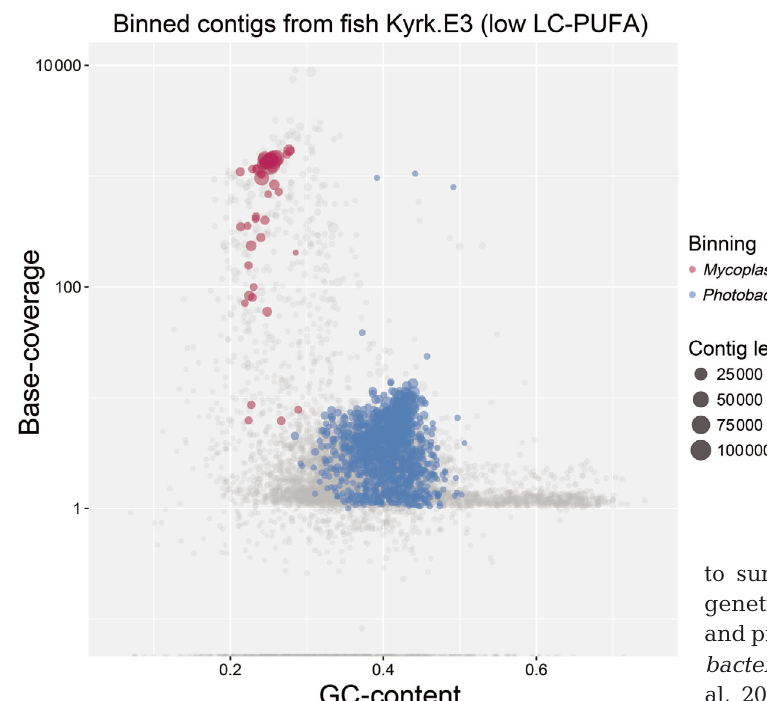
Fig. 5. Contig binning. Each dot corresponds to an assembled con- tig, positioned according to its GC content and base coverage. Col- ored dots correspond to contigs classified as Mycoplasma (red) or Photobacterium (blue). Note that the blue dots were binned into 2 separate bins, both classified as Photobacterium . All grey dots are unclassified